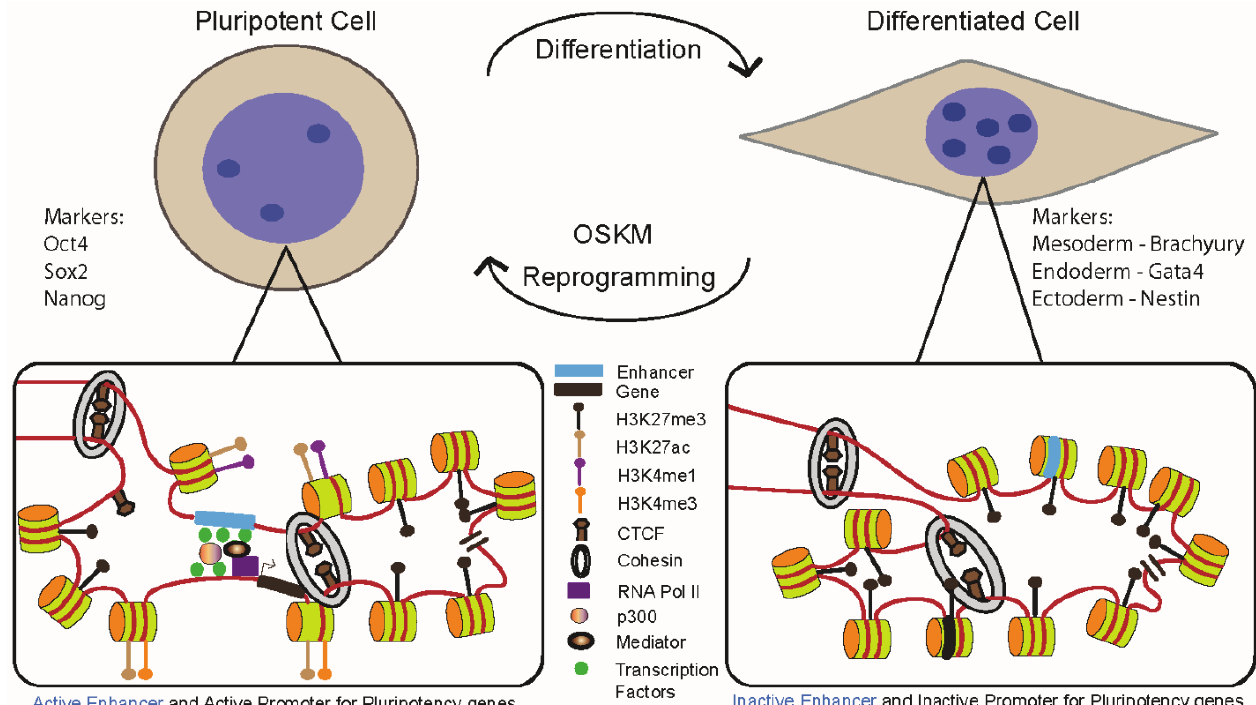
Figure 1. Changes in chromatin accessibility and modification drive the processes of differentiation and reprogramming. Pluripotent cells possess less compact chromatin compared to differentiated cells (light and medium intensity blue, respectively) and lack the compact chromocentres (dark blue) present in differentiated cells (top). The more open chromatin configuration in ES and iPS cells creates less nucleosome compaction (bottom left); as a result, nucleosomes are found in smaller clutches in ES and iPS cells as indicated by two clutches of four and seven nucleosomes, respectively. On the right the more compact chromatin of differentiated cells displays a greater overall density of nucleosomes and larger clutches of nucleosomes. Despite this chromatin compaction in differentiated cells, the reprogramming factors, OSKM, can access enhancer regions in condensed chromatin (blue bar), initiate chromatin remodeling at the enhancer, lead to chromatin remodeling at the gene (black bar) TSS, and eventually activate target genes as cells acquire the iPS state. This process converts the heterochromatic regions in fibroblasts marked by H4K27me3 to euchromatic regions in the iPS cells marked by H3K27ac and H3K4me1 or H3K4me3 at the enhancer and promoter respectively. CTCF and cohesin are found at both tissue-specific and constitutive chromatin loops. The coactivators (p300 and the mediator complex) are found at tissue-specific enhancer-promoter chromatin loops and are thought to bridge transcription factors at distal enhancers to the RNA polymerase II complex at the gene